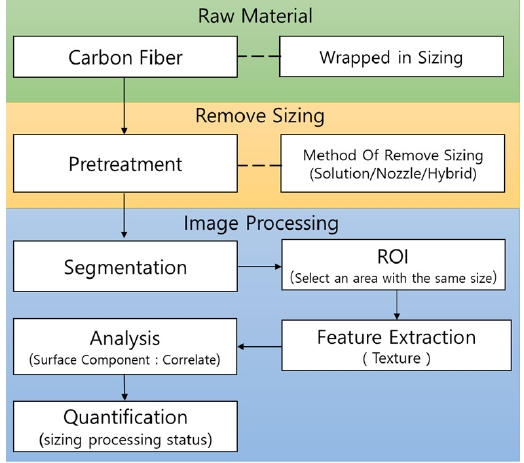
Figure 1. Proposed algorithm.